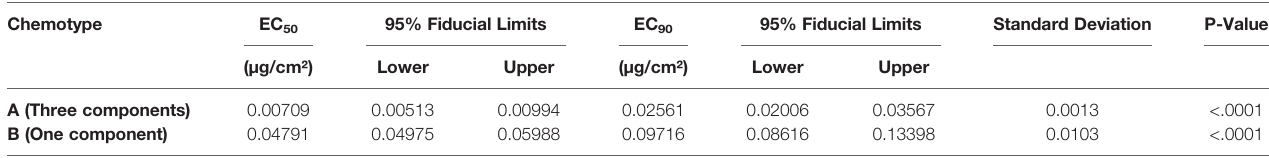
TABLE 1 | EC 50 and EC 90 values (μg/cm² of fi lter paper) and their 95% fi ducial limits, standard deviations, and P values obtained from evaluation in the bridge bioassay of oleoresins collected from two chemotypes of S habrochaites LA2329. Chemotype